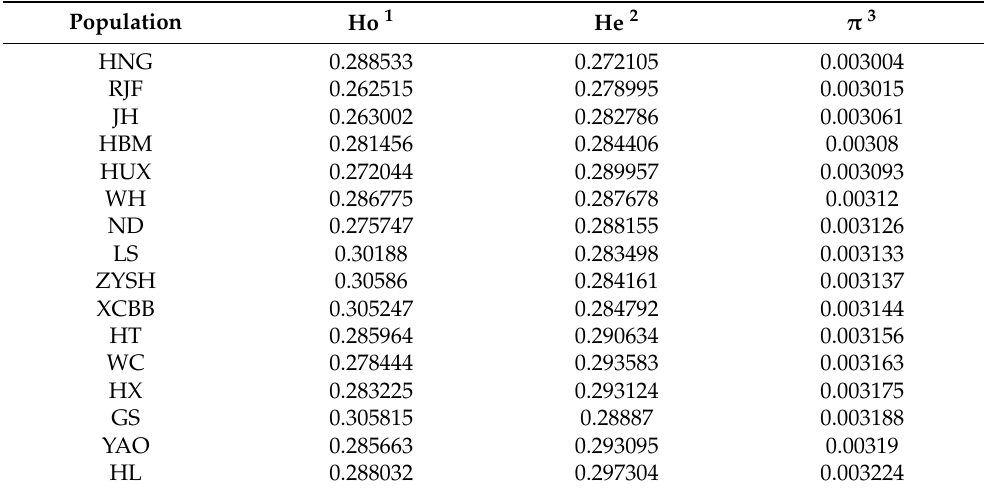
Table 1. The genetic diversity estimates for different indigenous chicken breeds and red jungle fowl.